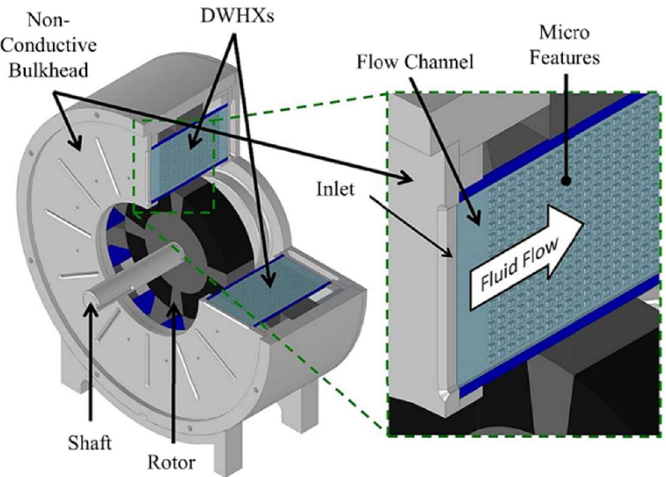
Figure 11. An electrical machine with in-slot microchannel heat exchangers [35].